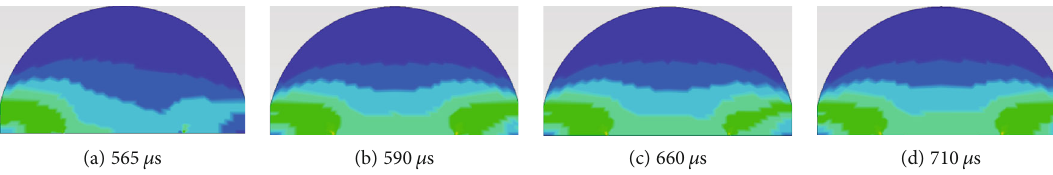
Figure 10: Stress distribution in CSTFBD specimens at di ff erent times.